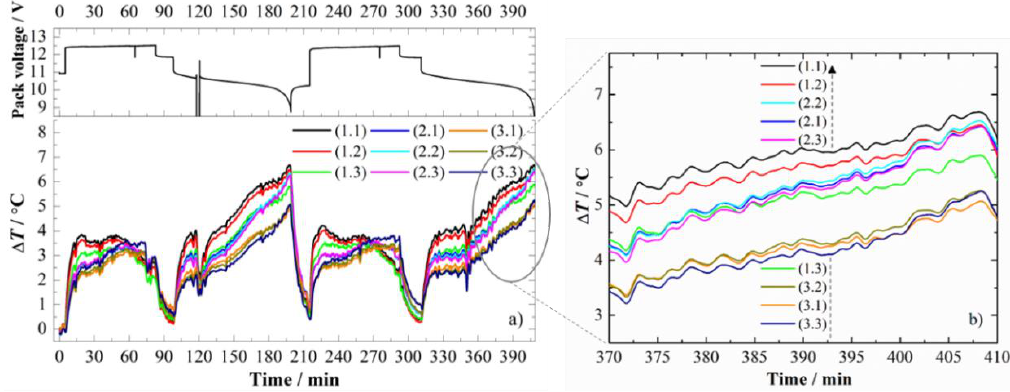
Figure 4. ( a ) Temperature variations during two cycling tests in all the LiPB surface positions as a function of the pack voltage discharge rate at 0.7 C. ( b ) Enlarged image representing the temperature variations recorded by the 9 FBG sensors inscribed in fiber 2 during the CC discharge step at 0.7 C.